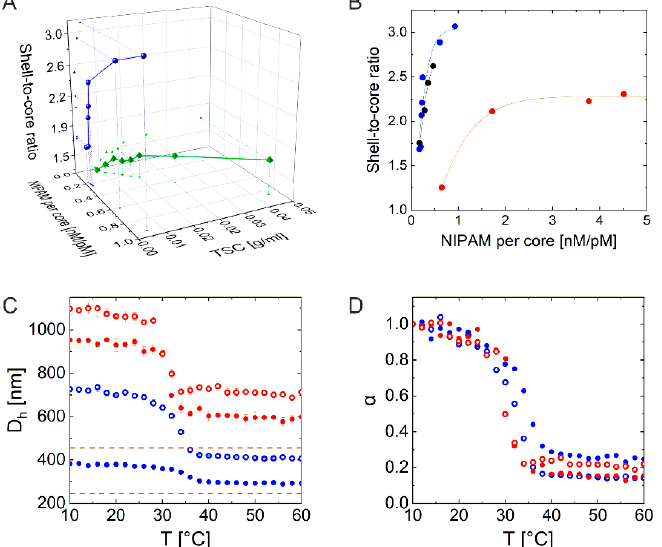
Figure 2. ( A ) 3D plot of shell growth on C 245 measured by DLS (depicted as shell-to-core ratio) in dependence of the NIPAM concentration per number of cores in nM/pM and TSC in g/mL. Blue: C 245 encapsulation via proposed protocol, green: according to [24]. ( B ) Shell growth on differently sized cores illustrated as the shell-to-core ratio in dependence of the NIPAM feed concentration per number of cores in nM/pM. Blue: C 245 , black: C 388 , red: C 455 . The solid lines correspond to the Gompertz fit of the growth. ( C ) Swelling curves of C 245 S 1.7 (filled blue), C 245 S 2.9 (empty blue), C 455 S 2.1 (filled red) and C 455 S 2.3 (empty red). The dotted lines represent the diameter of the core measured by TEM. ( D ) Calculated deswelling ratio of corresponding CS microgels from ( C